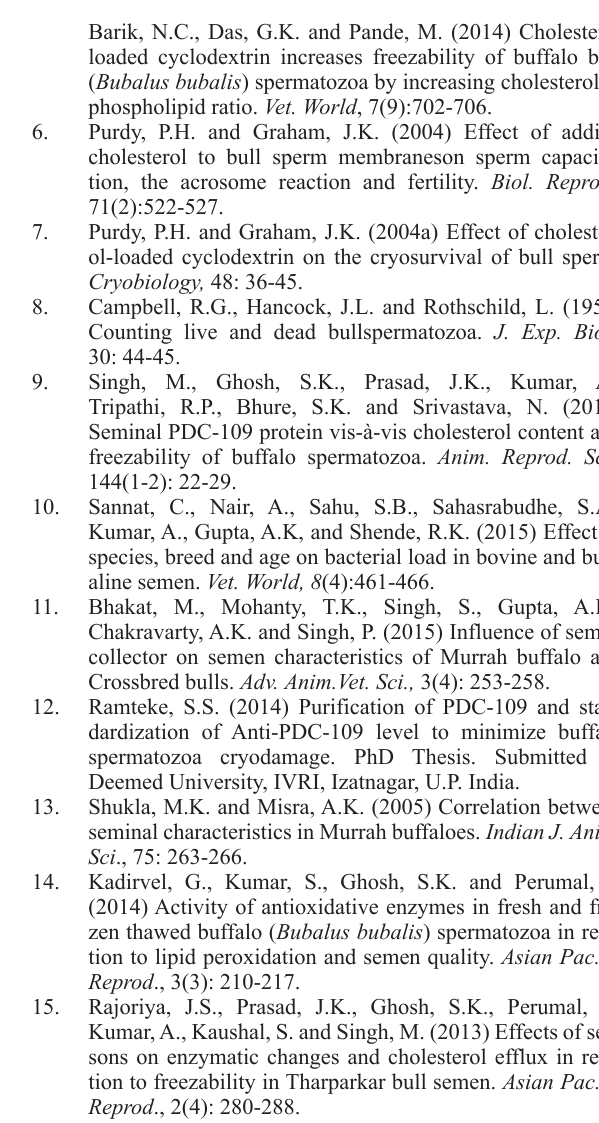
Values bearing different superscripts in upper case letters in a row differ significantly at 5% (p<0.05) and in lower case letters in a row differ significantly at 1% (p≤0.01). SE=Standard error